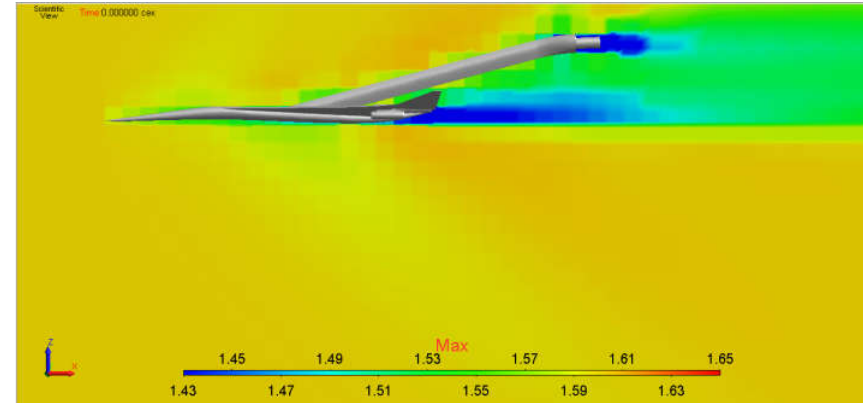
Figure 21. Mach number field, initialization (LM1021).